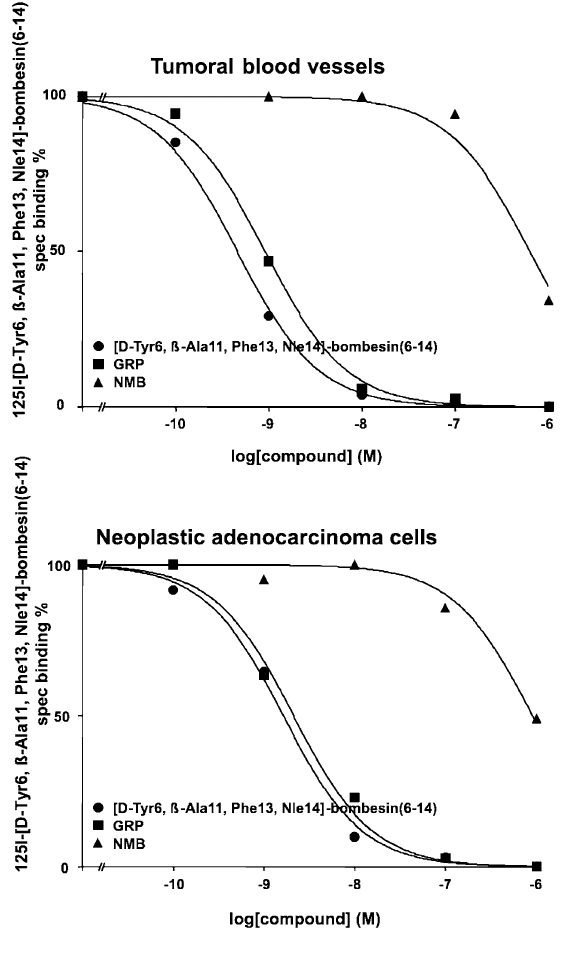
Fig. 6. Competition curves in representative samples of tumoral vessels and ovarian clear cell adenocarcinoma using 125 I-[D-Tyr 6 , ß-Ala 11 , Phe 13 , Nle 14 ]-bombesin(6-14) as radioligand. Successive tissue sections were incubated with the radioligand and increasing concentrations of [D-Tyr 6 , ß-Ala 11 , Phe 13 , Nle 14 ]-bombesin(6-14) ( " ) and unlabeled GRP ( 2 ) and NMB ( Q ). High-affinity dis- placement of the tracer was found with [D-Tyr 6 , ß-Ala 11 , Phe 13 , Nle 14 ]-bombesin(6-14) and GRP, whereas neuromedin B induced only displacement at lower affinity. Non-specific binding was sub- tracted from all values. The observed rank order of potencies of these analogs is compatible with the GRP-receptor